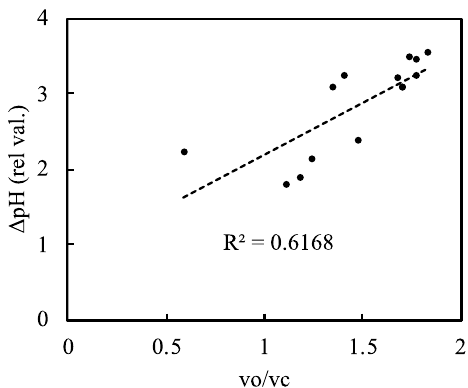
Figure 7. Relationship between the relative photorespiration activity (vo / vc) and ∆ pH across the thylakoid membranes in rice leaves. The RuBP carboxylase reaction rate (vc) and the RuBP oxygenase reaction rate (vo) were estimated as described in the Materials and Methods. Data of vc and vo were simultaneously measured with ∆ pH in Figure 6A. The dashed line in the graph is the regression line and the coefficient of determination was 0.6168 (p<0.001).